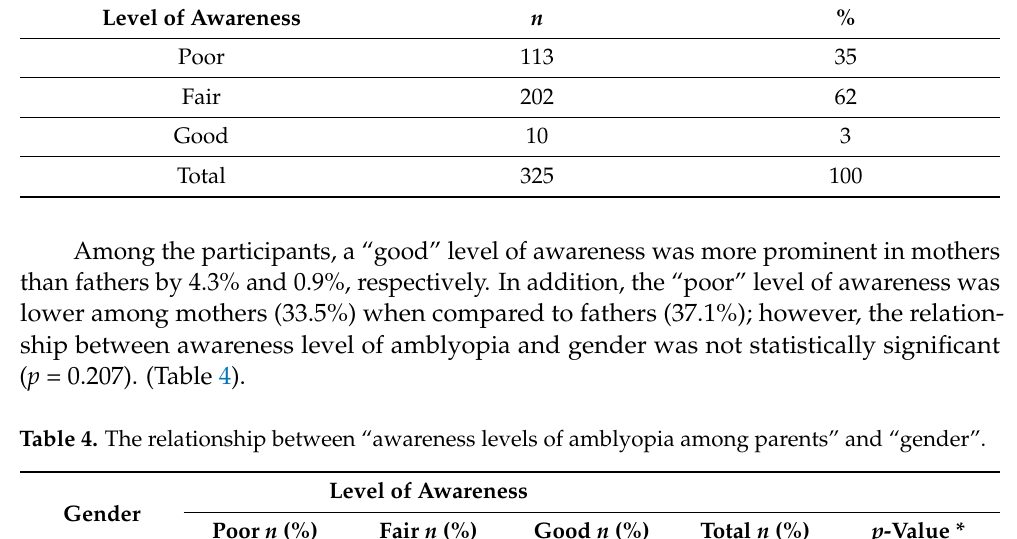
Table 4. The relationship between “awareness levels of amblyopia among parents” and “gender”. Gender